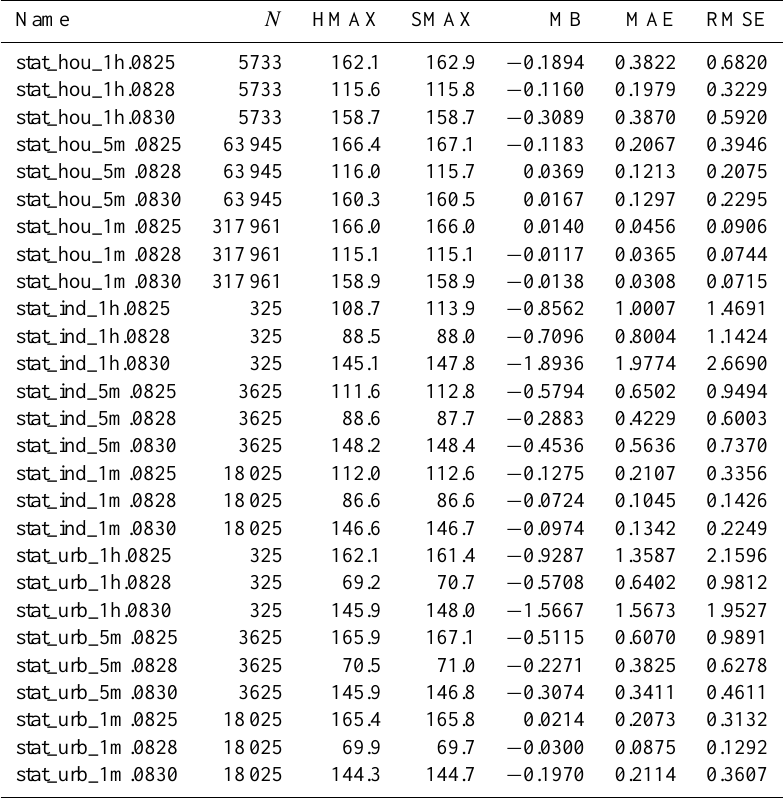
Table 2. Summary of statistical parameters for STOPS and CMAQ predicted ozone mixing ratios, when STOPS was used in the stationary mode. “hou” indicates results from the Houston domain, “ind” from the industrial domain, and “urb” from the urban domain.